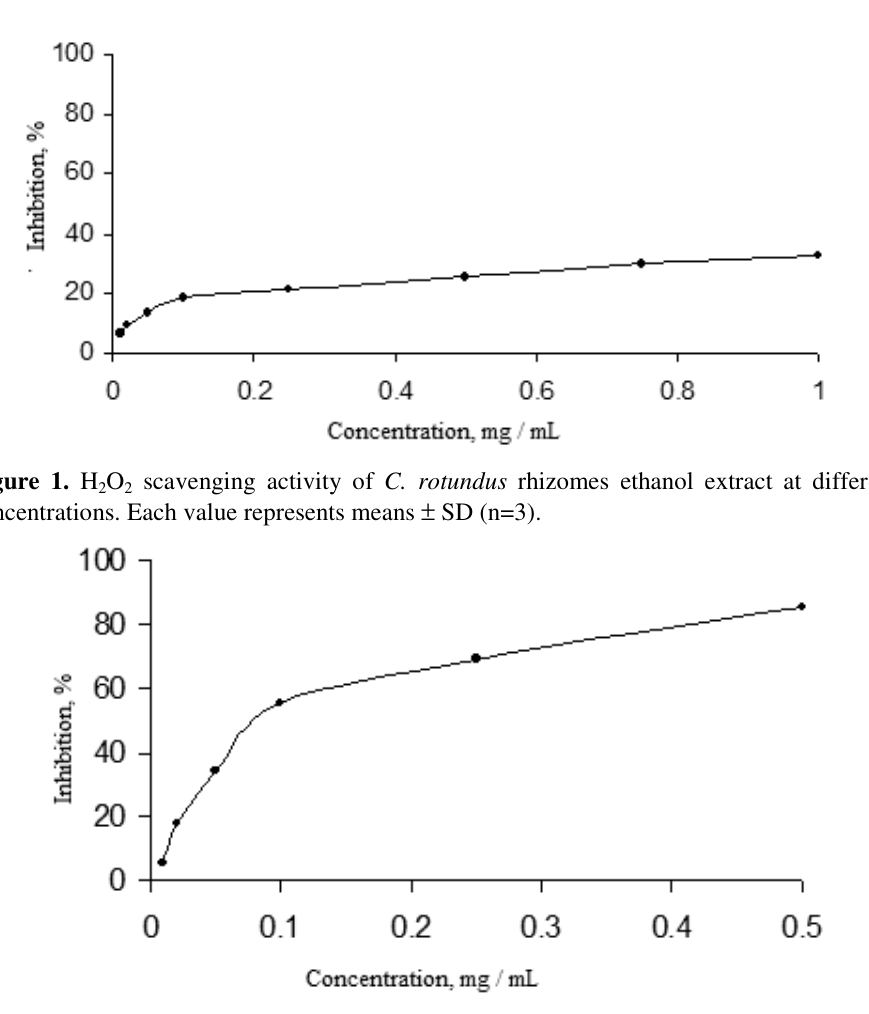
Figure 2. Ferrous ion chelating activity of C. rotundus rhizomes ethanol extract at different concentrations. Each value represents means ± SD